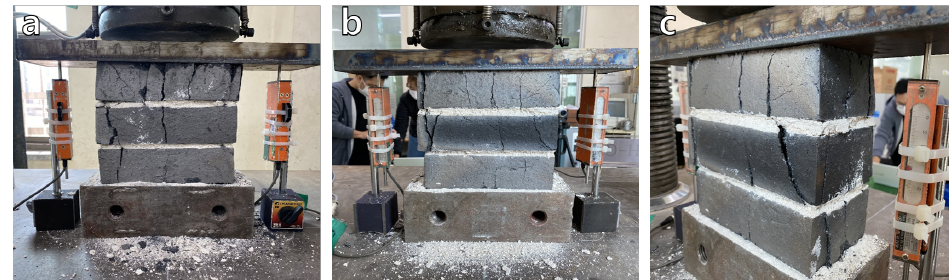
Figure 14. Failure mode compression test. ( a ) Front view ( b ) backside view ( c ) side